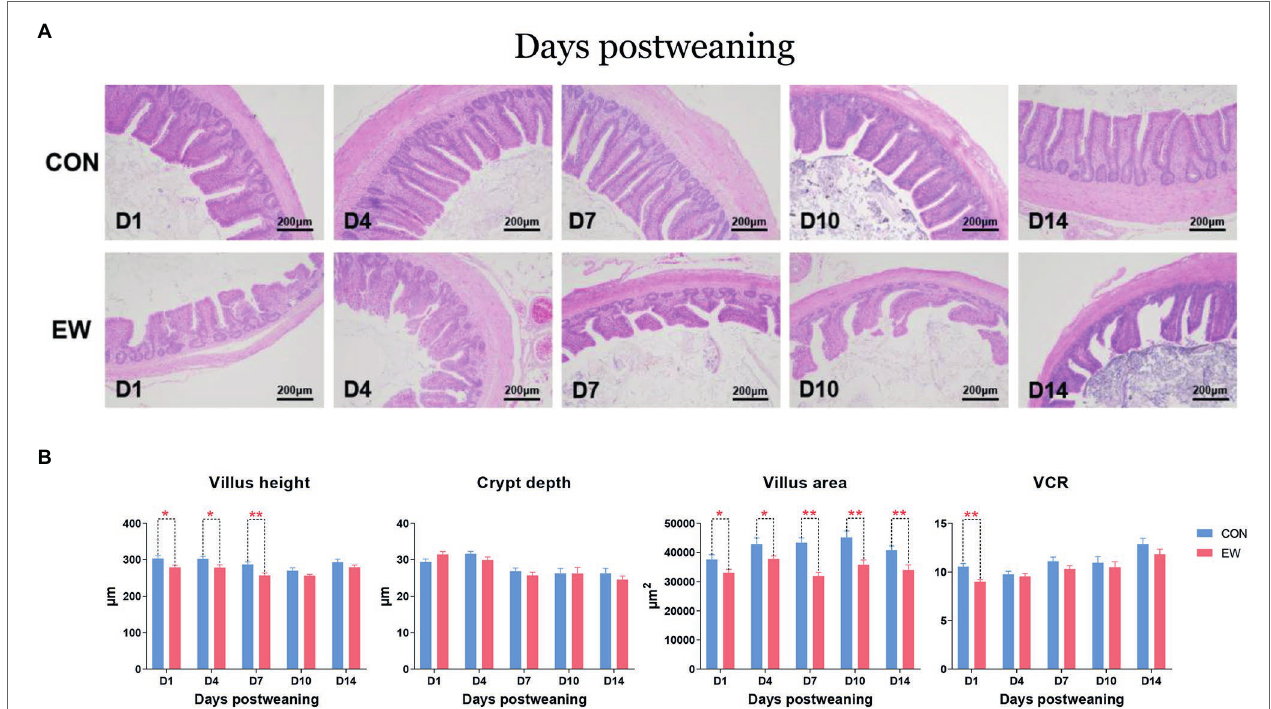
FIGURE 7 | Representative haematoxylin and eosin-stained morphology (A) and morphometric traits (B) in the ileum of squabs between the CON and the EW groups. D1, D4, D7, D10, and D14 means 1, 4, 7, 10, and 14 days postweaning, respectively. Values are means with their standard errors of eight squabs. * and ** mean p < 0.05 and p < 0.01, respectively, within each time points postweaning. CON, control group; EW, early weaning group; VCR, the ratio of villi to crypt.